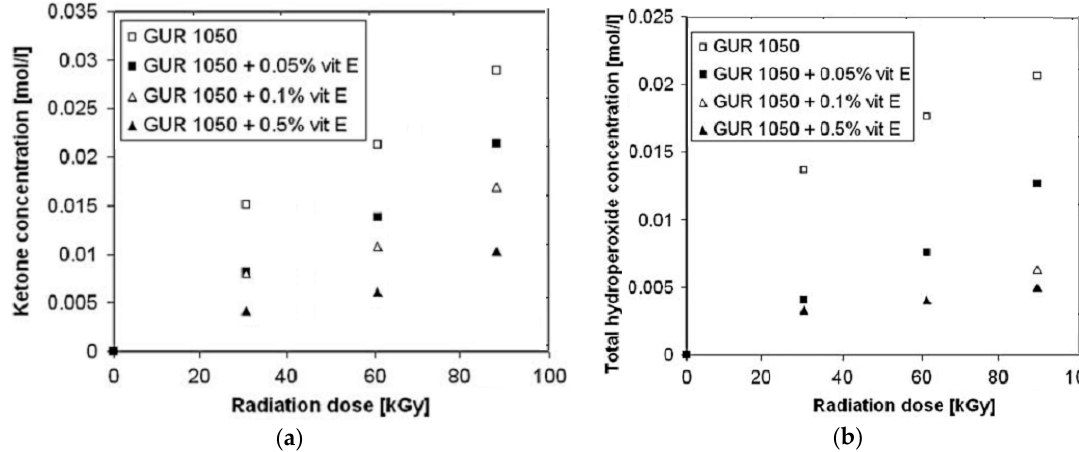
Figure 6. The effect of radiation dose on the amount of oxidation products after 2390 h of aging time ( a ) ketones; ( b ) total hydroperoxides. Reprinted with permission from [99].